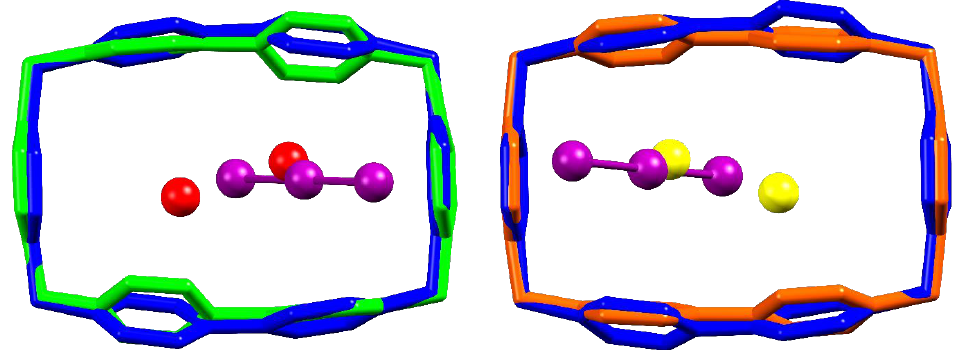
Figure 4. Comparison of host-guest interaction for BB ... I 3 in I 3 @BB(I 3 ) 3 · 2DMSO (blue and violet) and BB ... I − in (BB)I 4 · 8H 2 O (green and red: molecule A; orange and yellow: molecule B). Superimposition obtained by overlap of the four C atoms of BB methylenic corners (RMS = 0.110 and 0.057 for molecule A and B, respectively).